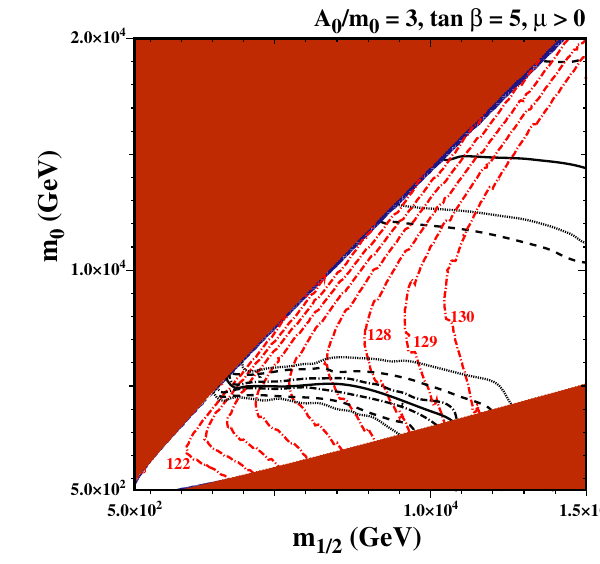
Fig. 2 The ( m 1 / 2 , m 0 ) plane for tan β = 5, A 0 / m 0 = 3 and μ > 0 in the CMSSM with GUT-scale universality, exhibiting in black the con- straint on the lifetime of p → K + ¯ ν for the central value of all param- eters in solid, for a one-standard-deviation variations in the hadronic matrix elements of the relevant 3-quark operators indicated in Table 3 (dot-dashed lines), and for a one-standard-deviation variations in both the hadronic matrix elements and α s (dotted). The red dot-dashed con- tours show the lightest Higgs mass as calculated using FeynHiggs [132–137]. In the upper red shaded region, the lighter stop is the LSP, andinthelowerredshadedregion,thelighterstauistheLSP.Intheblue strip along the stop LSP region, the LSP has an enlarged relic density range, 0 . 01 < (cid:23) χ h 2 < 2 . 0, to enhance its visibility